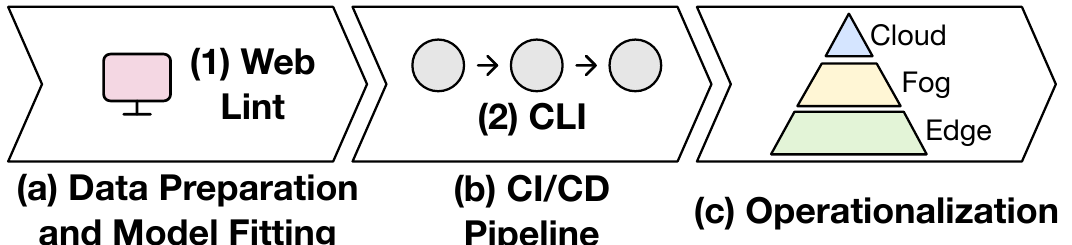
Figure 20. Integration of the PADLib, CLI, and Web Lint tools in the delivery